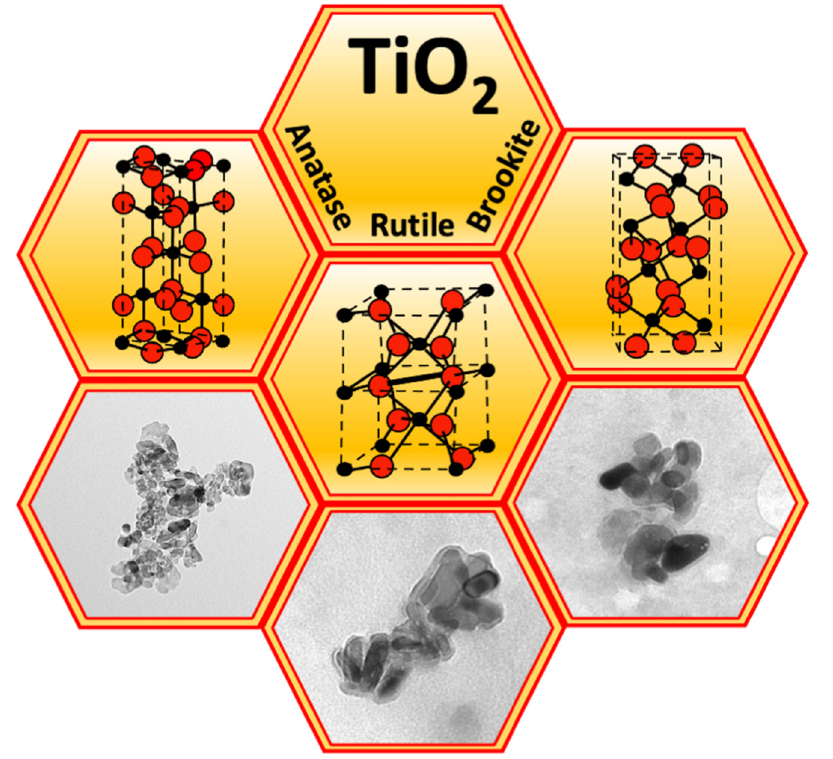
Figure 1. Crystalline structures of anatase, rutile, and brookite TiO 2 (spheres: red O 2 , black Ti) and transmission electron microscopy images of the corresponding TiO 2 NPs.